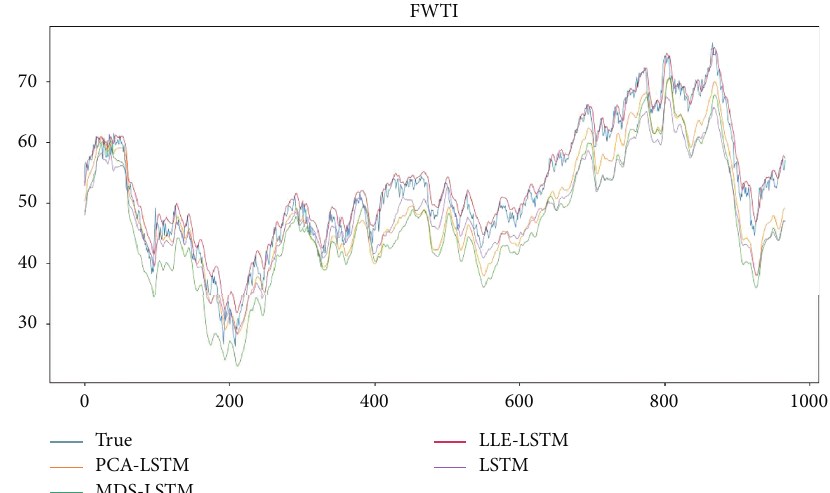
Figure 12: Prediction results of crude oil future prices by the LSTM benchmark model.